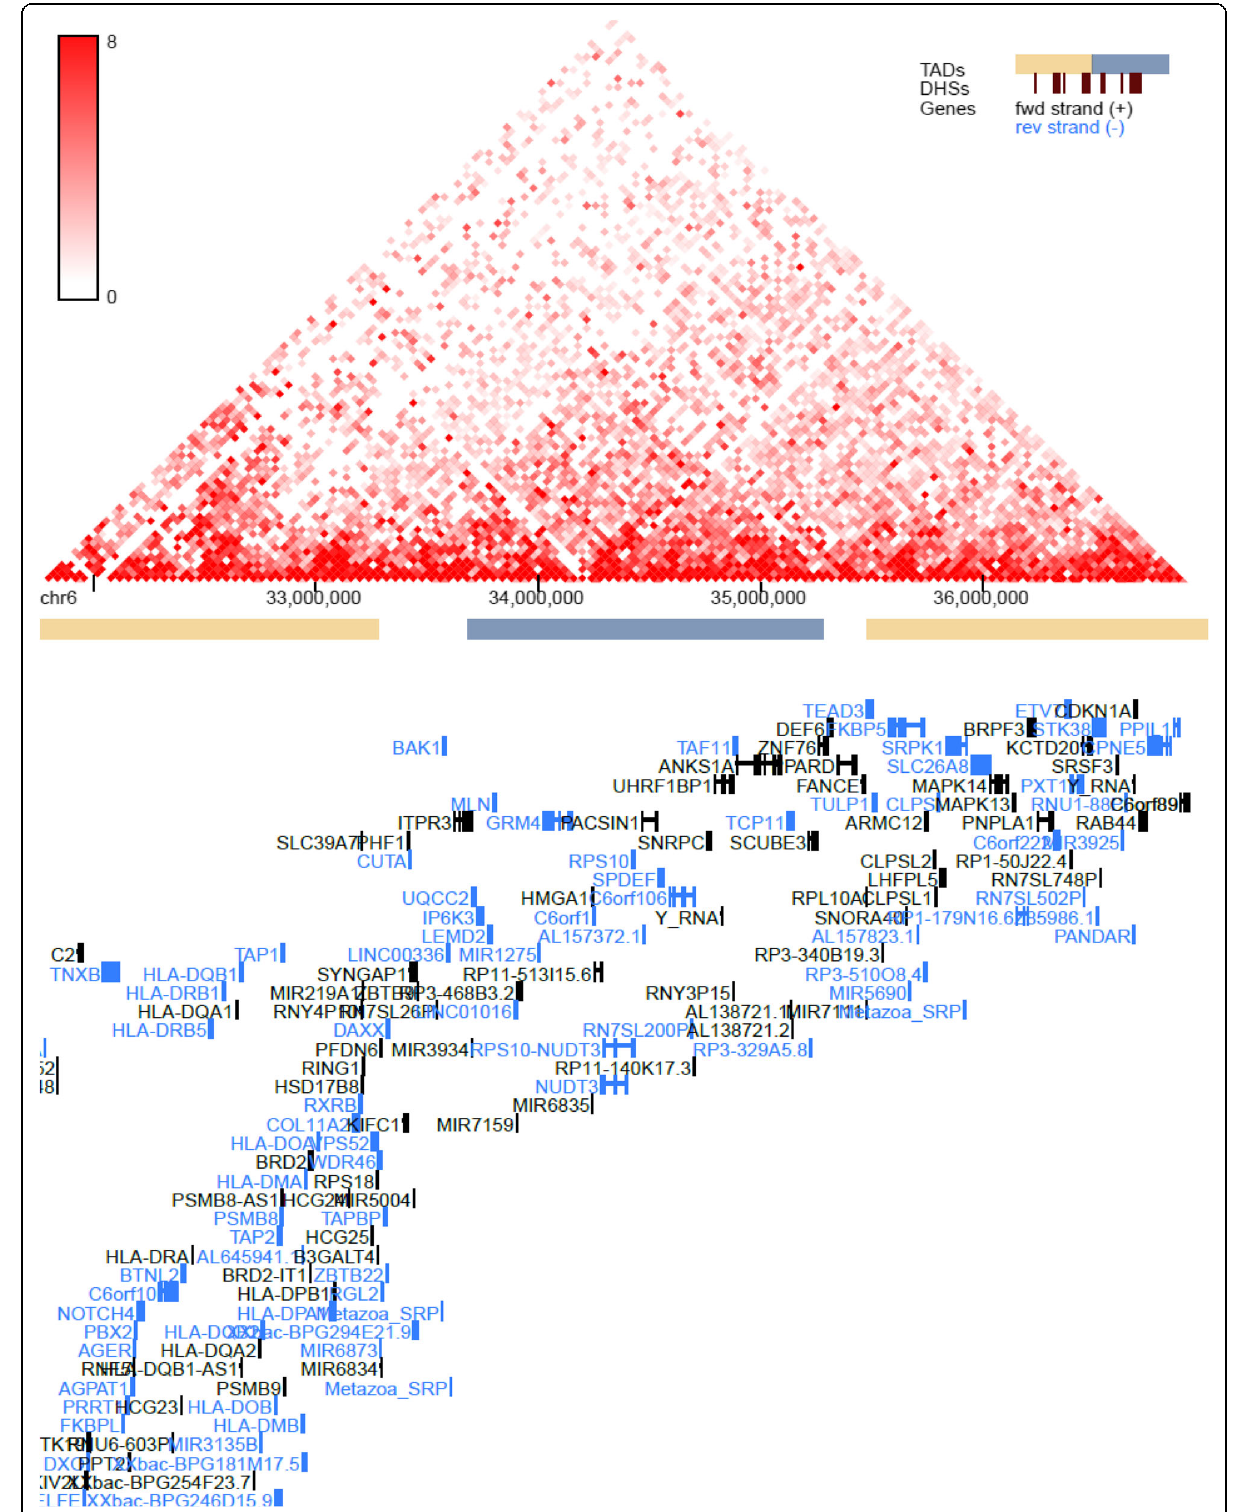
Fig. 7 NUDT3 expression in chromosome 6 (psoas